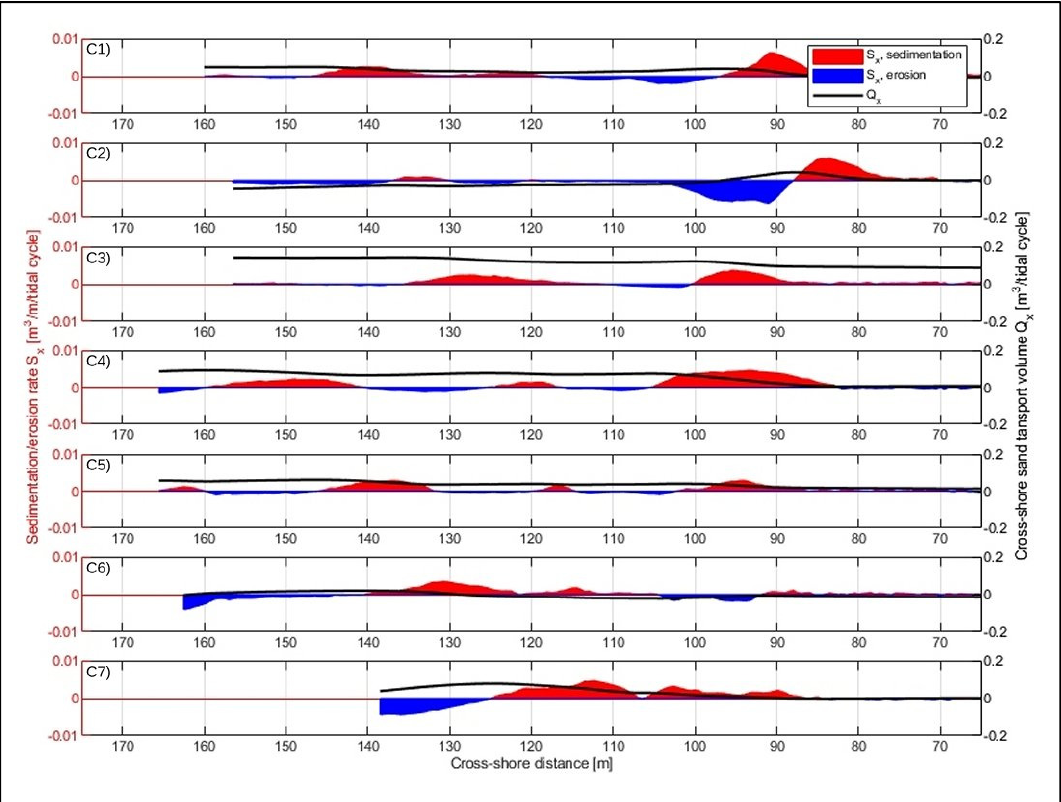
Figure 14. Sedimentation and erosion rate, S x , and cross-shore sediment transport volumes, Q x , in period C from 31 January to 21 February 2017 (C1–C7, see Figure 13) based on tide-to-tide beach height differences. Positive/negative Qx values indicate shoreward/seaward sand transport, respectively. Tide-to-tide analysis has proven to be di ffi cult during this period due to the small daily height changes which are within the estimated errors of the laser scanner. Figure 13 shows the evolution